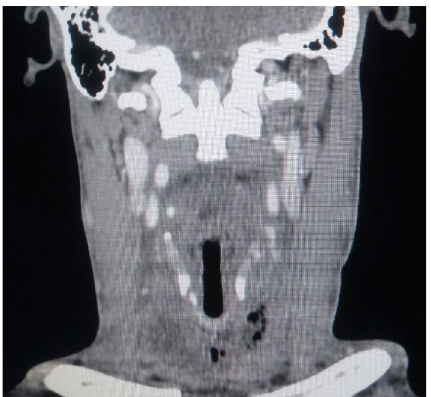
Figure 2. Computed tomography of the neck and thorax in coronal view showing a purulent collection medial do the sternocleidomastoid muscle.